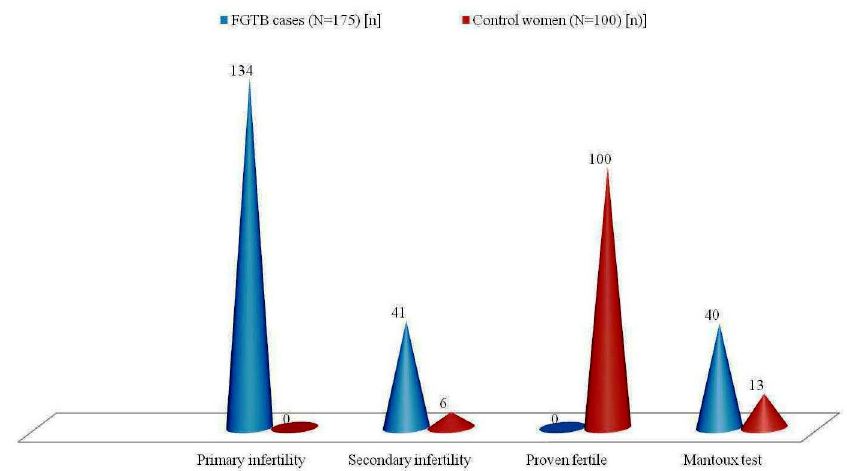
Fig 4. Association of infertility and Mantoux test among infertile women with female genital tuberculosis (FGTB) and healthy control women (HCW) without TB.